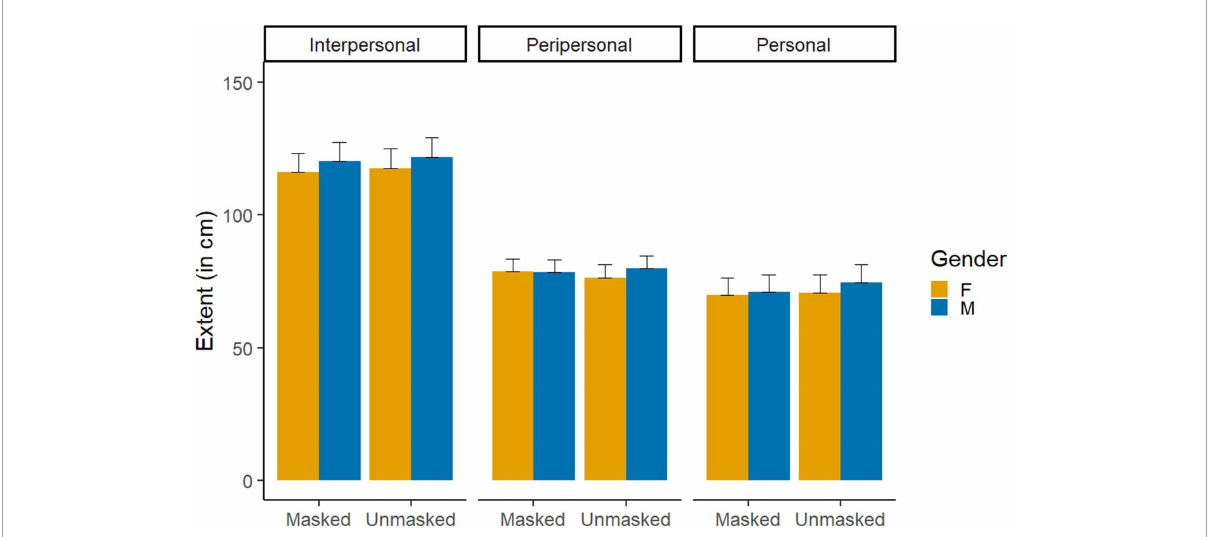
FIGURE2 Mean interpersonal space (IPS), peripersonal space (PPS), and personal space (PS) when facing male and female characters wearing a face mask or not. Error bars represent the standard errors.